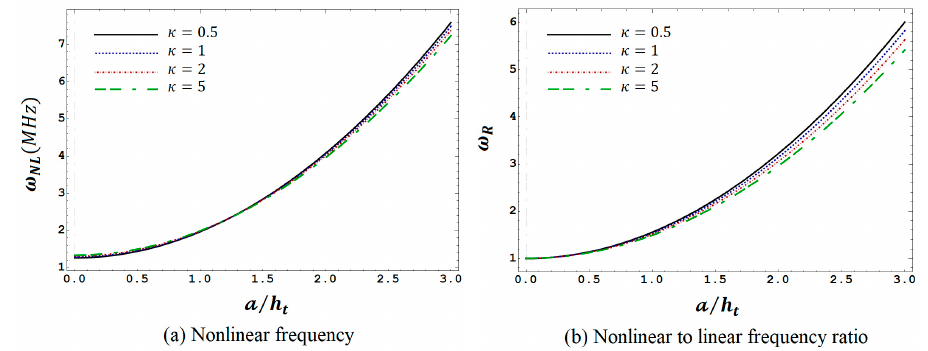
Figure 3. Variation of the first-order nonlinear frequency and nonlinear-to-linear frequency ratio of a GPL-reinforced sandwich beam with respect to an increasing amplitude of vibrations, and for di ff erent power-law parameters ( h c / h t = 0.6, N = 10, Γ b = 1%, L / h t = 10).